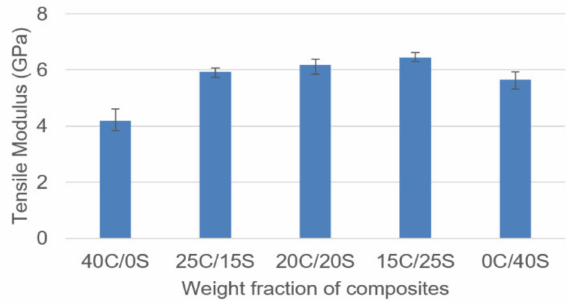
Figure 6. Tensile modulus vs. weight fraction of C/S composites.